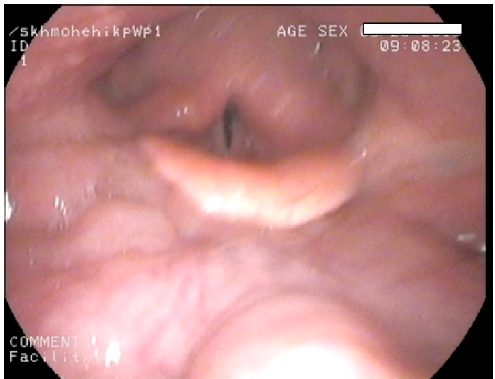
Figure 1. Nasendoscopy pictures showing a normal larynx: the vallecula, epiglottis, glottic inlet, and posterior larynx can be clearly seen.